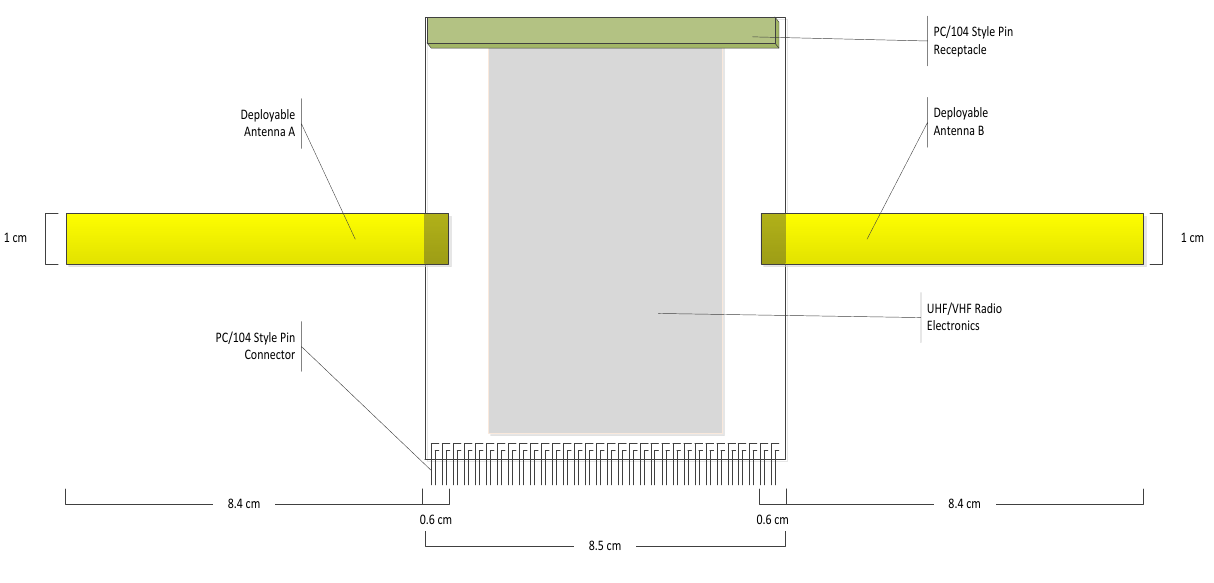
Figure 2. TT&C Board Antenna